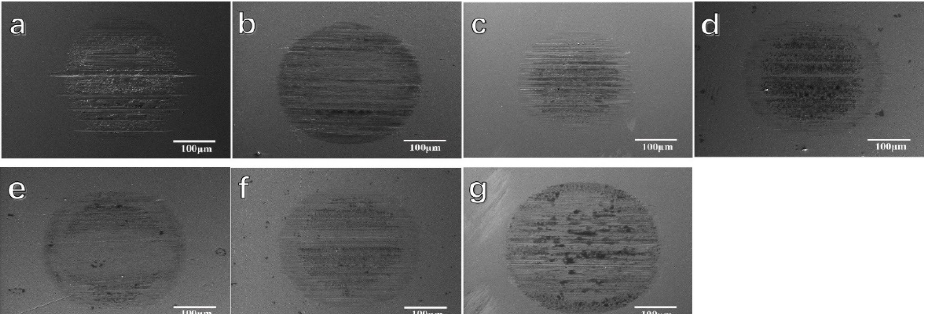
Figure 8. SEM images of wear scars on the surface of mating balls lubrication with different content of Cu nanoparticles in PAO6: ( a ) 0 wt.%, ( b ) 0.05 wt.%, ( c ) 0.1 wt.%, ( d ) 0.3 wt.%, ( e ) 0.5 wt.%, ( f ) 1.0 wt.%, ( g ) 1.5 wt.%.